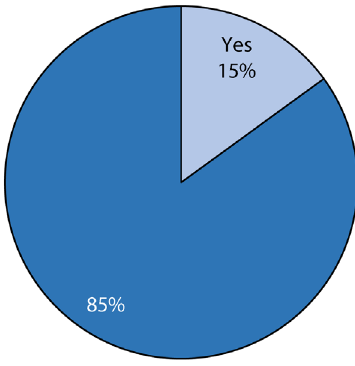
Figure 1: Prevalence of